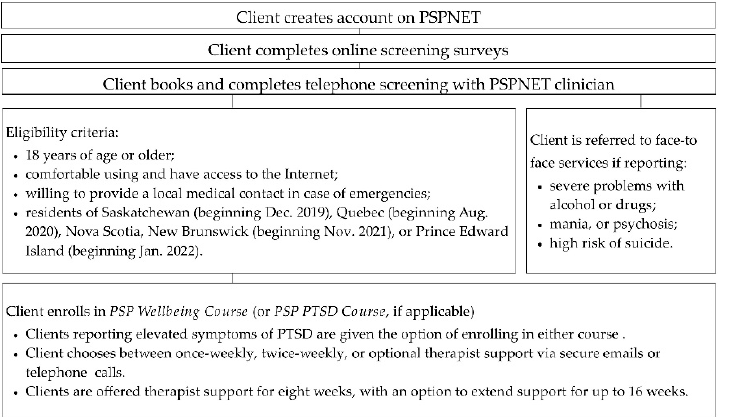
Figure 1. Process for enrolling in and completing the PSP Wellbeing Course.